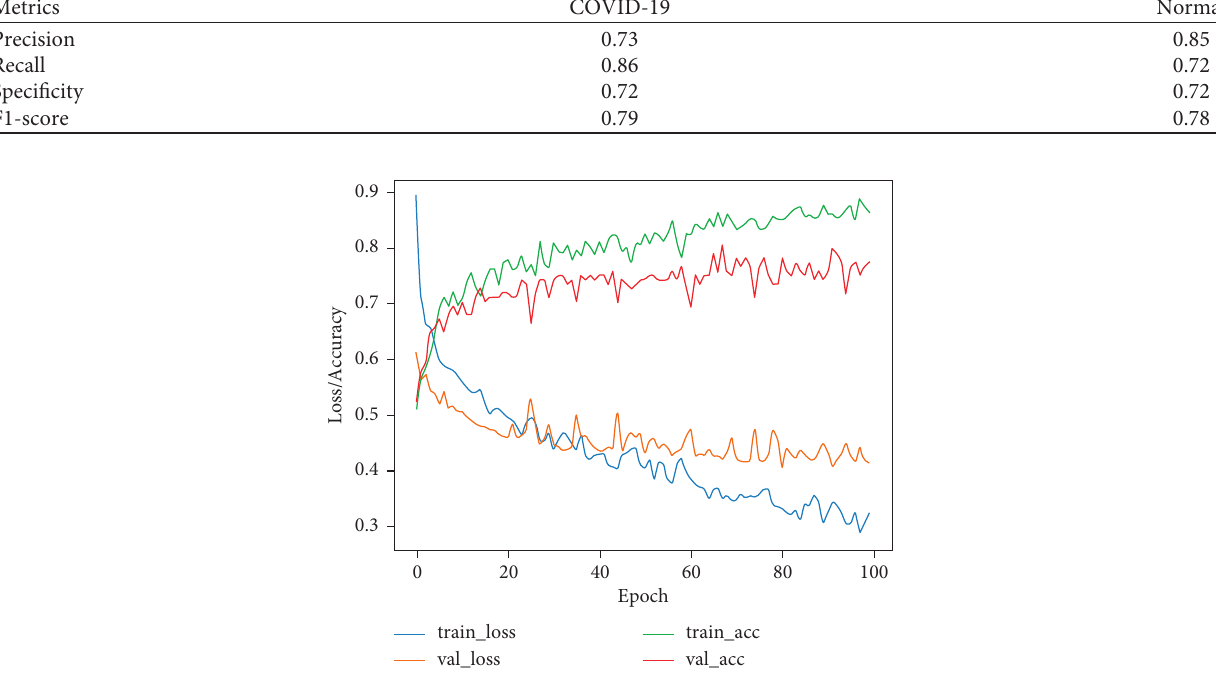
Figure 8: Accuracy and loss for COVID-19 detection.